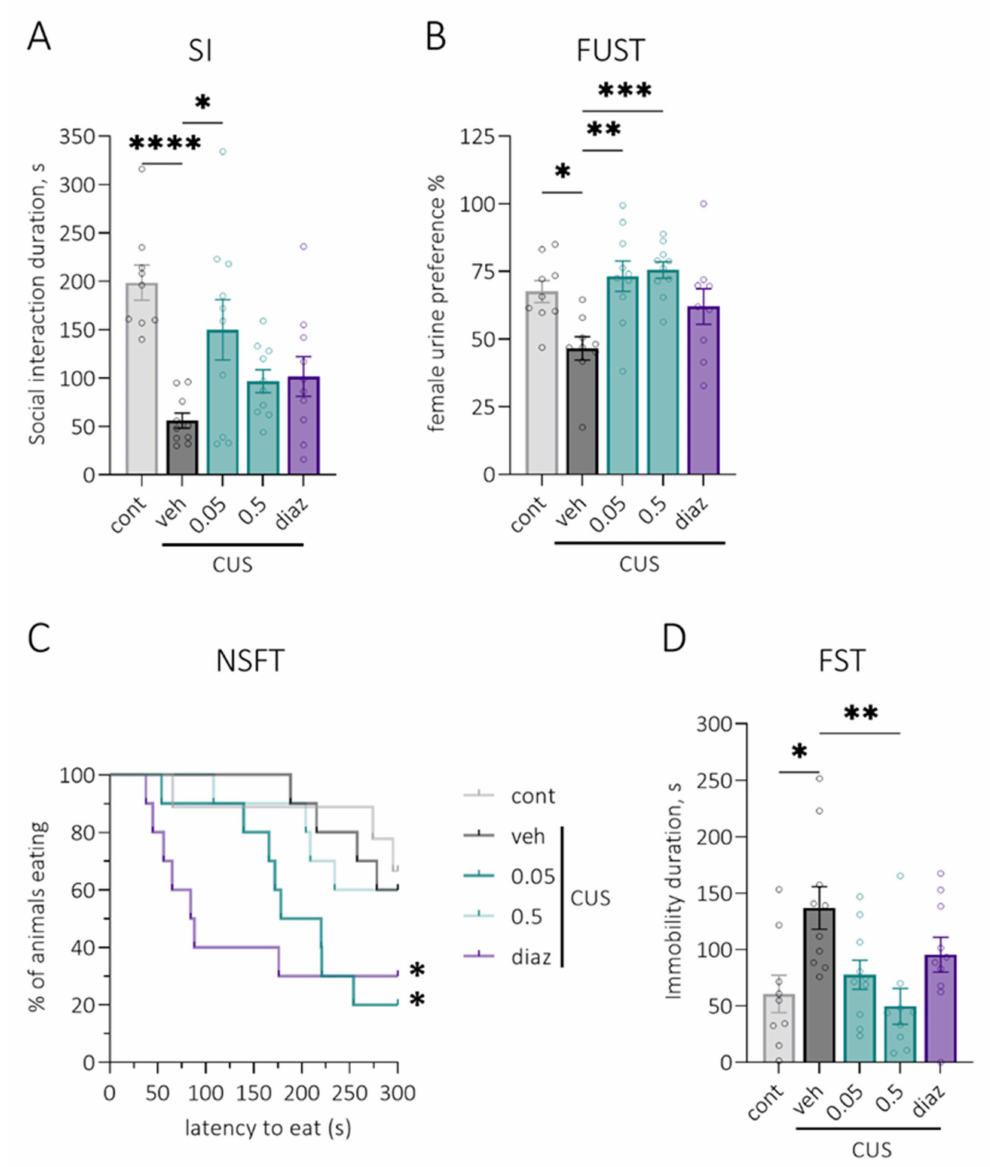
Figure 4. Anxiolytic- and antidepressant-like efficacy of LCGA-17 in the CUS model. Animals were exposed to chronic stress for 26 days, and control rats remained intact. Separate groups of rats ( n = 9) were treated with i.n. LCGA-17 (0.05 and 0.5 mg/kg) or diazepam (0.5 mg/kg, i.p.) or the vehicle for several days, followed by behavioral analyses. On the day of the experiment, substances were administered 30 min before the test. ( A ) In the SI test, the duration of social contact (s) was significantly decreased in vehicle-treated CUS-exposed rats, while LCGA-17 0.05 mg/kg (4 injections) significantly increased this parameter (H (5, 45) = 19.88, p = 0.0005; K–W, Dunn’s test); ( B ) In the FUST, CUS exposure led to a decreased preference for female urine (%); at the same time, LCGA-17 at both doses (8 injections) abolished the effect of stress on reward-seeking behavior (F (4, 40) = 5.62, p = 0.001; ANOVA, Dunnett’s test); ( C ) In the NSFT, latency to eat was not affected by stress, though 0.05 mg/kg LCGA-17 and diazepam administered for 11 days both decreased this parameter (chi- square = 11.67, p = 0.02; Log-rank Mantel–Cox test); ( D ) In the FST, stressed vehicle-treated rats spent more time immobile (s), while LCGA-17 (18 injections) dose-dependently decreased the immobility in this test (H (5, 45) = 14.99, p = 0.005; K–W, Dunn’s test). * p < 0.05, ** p < 0.01, *** p < 0.001, and **** p < 0.0001 vs. veh